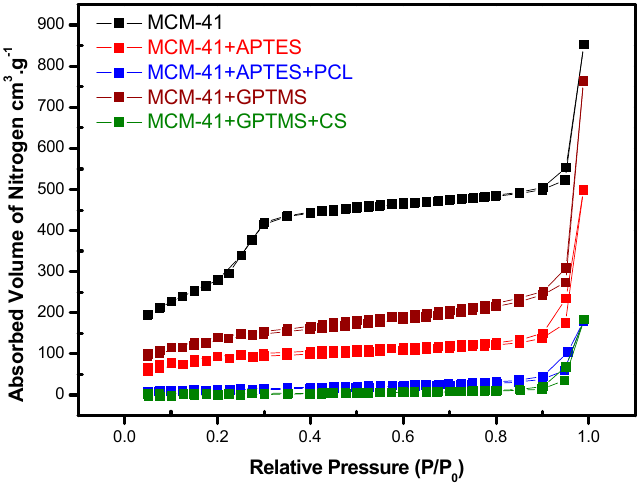
Figure 3. N 2 adsorption–desorption isotherms of pure MCM-41 modified with APTES-PCL and GPTMS-CS samples.